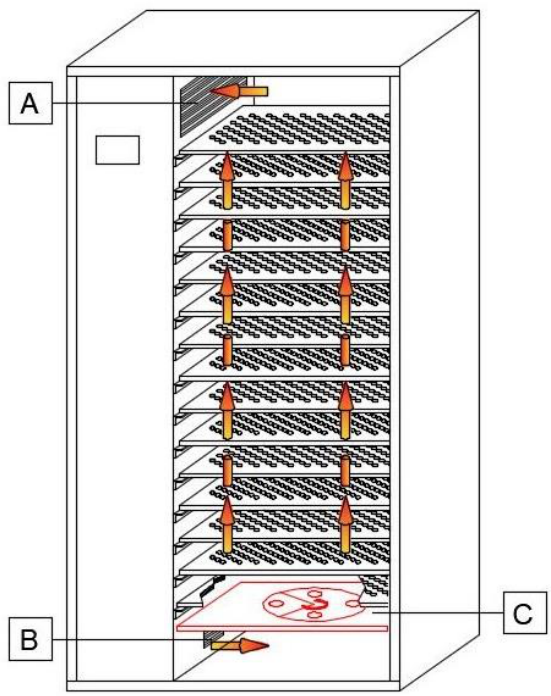
Figure 3. Diagram of air flow through a drying chamber, with modification 5. A—air inlet; B—air outlet; C—rotating disc. The arrows indicate the direction of the air flow.